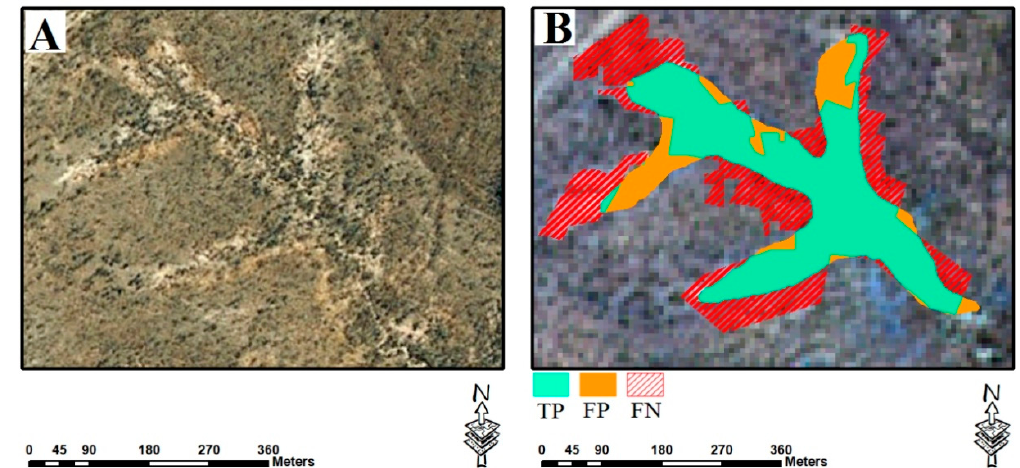
Figure 6. Graphical representation of metrics: TP, FP, and FN. ( A ) is the location of a selected gully feature on Google Earth, and ( B ) is the overlay of TP, FP, and FN of the same gully on Sentinel 2A image.